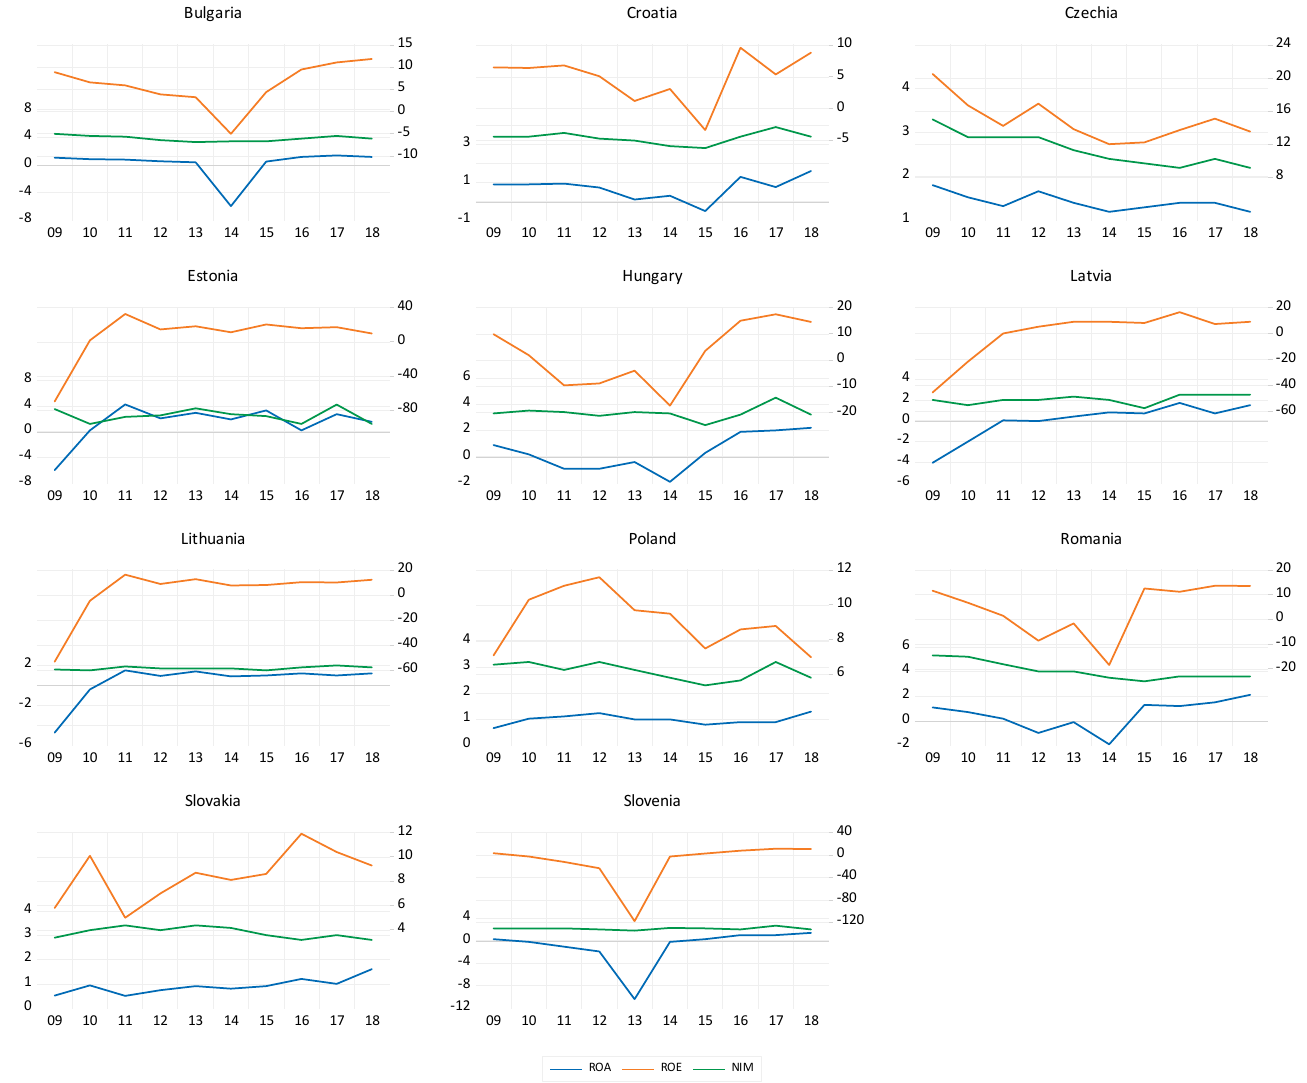
Figure 4. Banks’ profitability in CEE countries, 1995–2018 (%). ROA and NIM are represented on the left axis and ROE on the right axis.